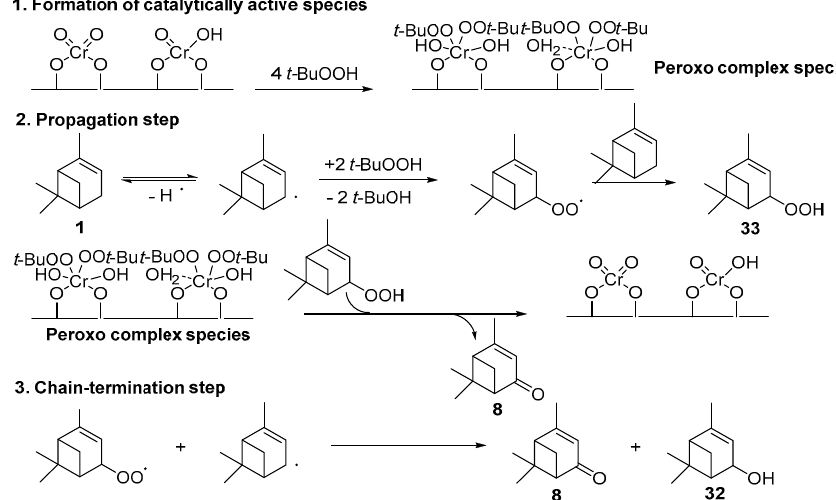
Scheme 12. Proposed mechanism for the oxidation of α -pinene over Cr-SBA-15 (adapted from reference [60]). Table 17. Iron- vs. chromium-MIL catalysts—a comparison in the oxidation of various terpenic olefins